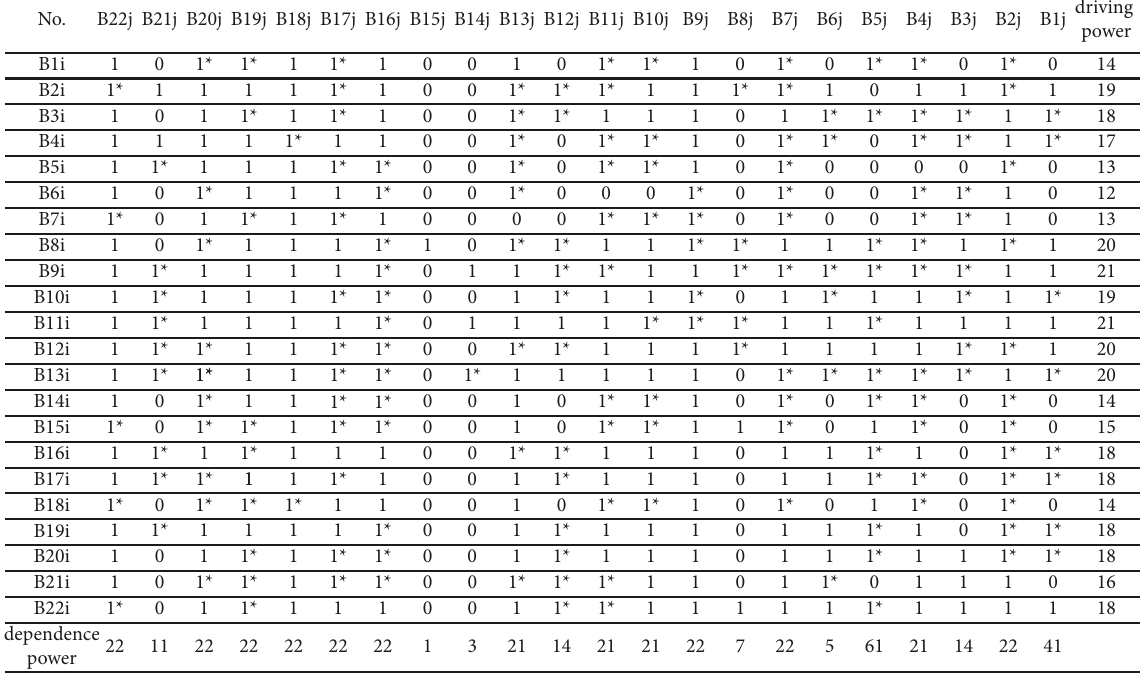
Table 10: Combined final reachability